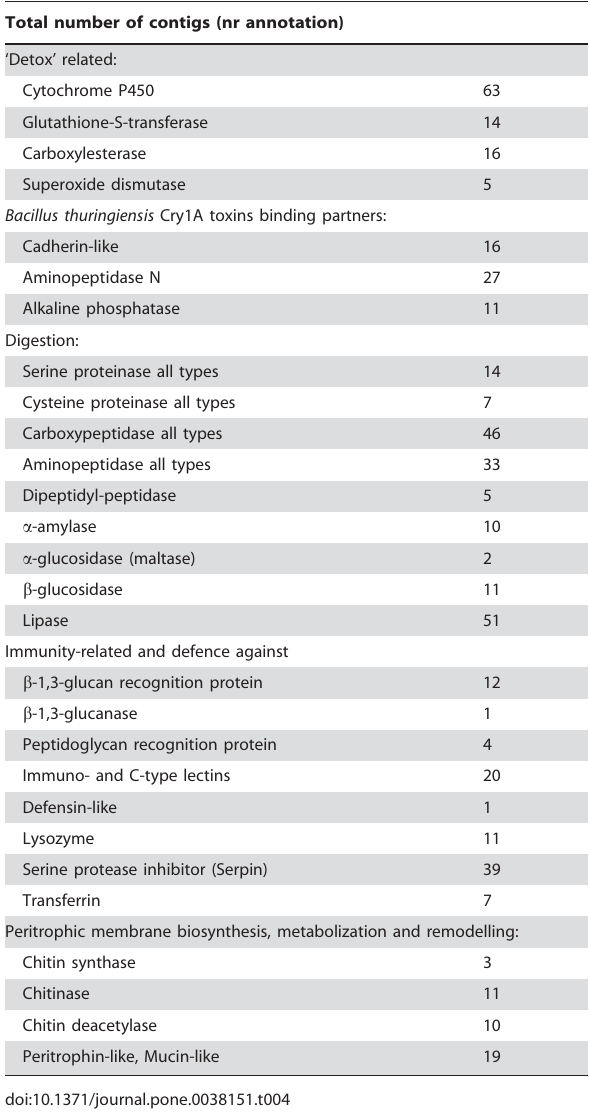
Table 4. Selection of genes of interest related to the larval midgut physiological